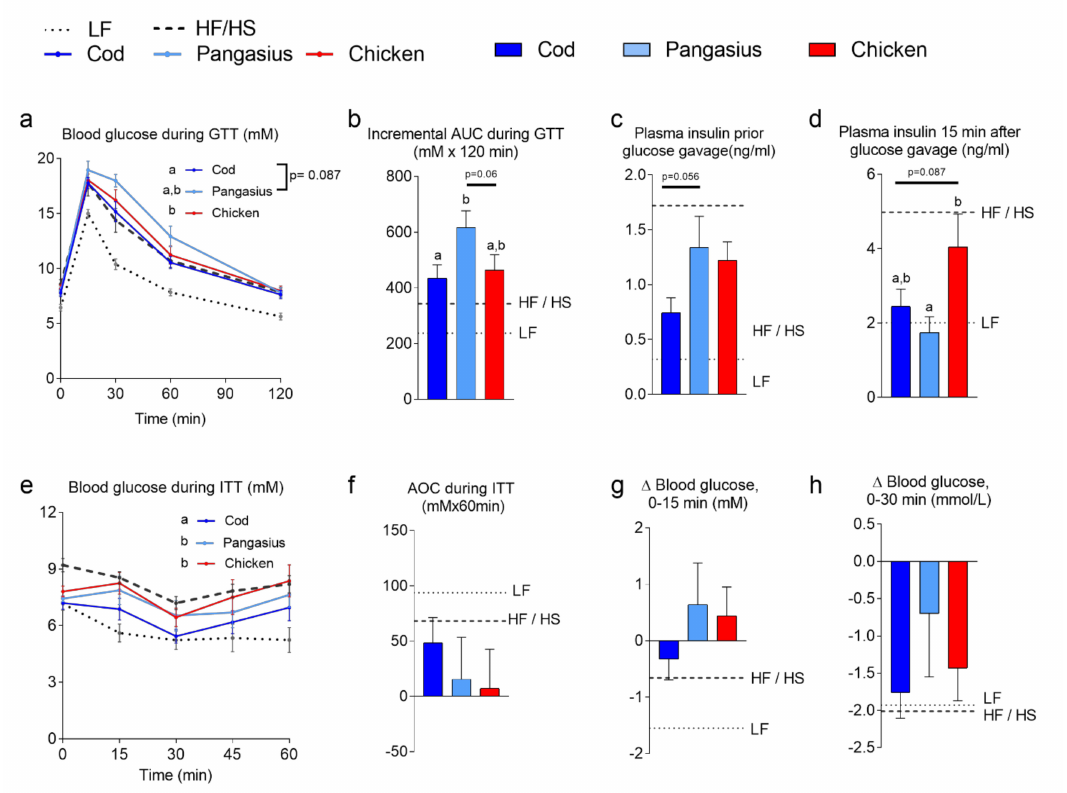
Figure 2. ( a ) Blood glucose levels during an oral glucose tolerance test (OGTT) performed in week 10 and ( b ) calculated incremental area under the curve (AUC) for the OGTT. ( c ) Plasma insulin levels after 5 h fasting prior to glucose injection. ( d ) Plasma insulin levels 15 min after glucose injection. ( e ) Blood glucose levels during the insulin tolerance test (ITT) in week 11 and ( f ) calculated decremental area over the curve (AOC) for the ITT. ( g , h ) Change in blood glucose from the fed state to 15 min (g) and 30 min (h) after insulin injection. Data are presented as the mean ± SEM ( n = 10) and di ff erent letters denote significant di ff erences ( p < 0.05) by one-way ANOVA using uncorrected Fisher’s LSD multiple comparison. Blood glucose data during OGTT and ITT were analyzed by repeated-measure one-way ANOVA and Fisher’s LSD multiple comparison post hoc